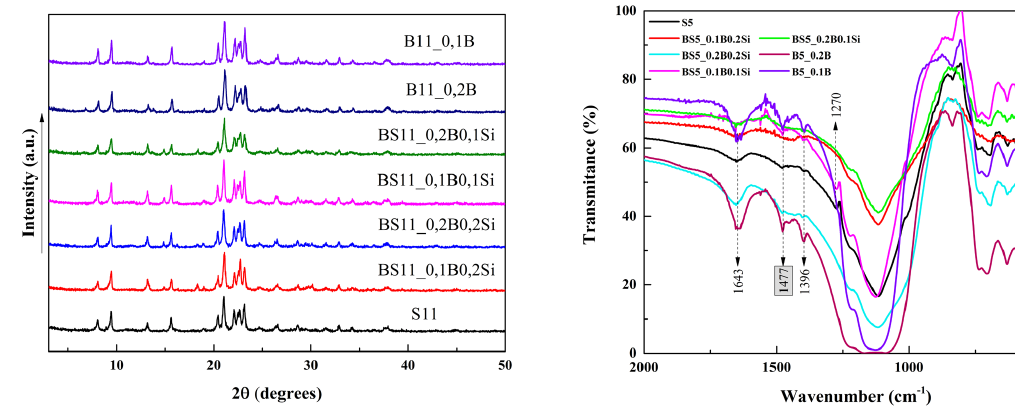
Figure 2. XRD profiles of samples synthesized with different compositions of the AEL structure.